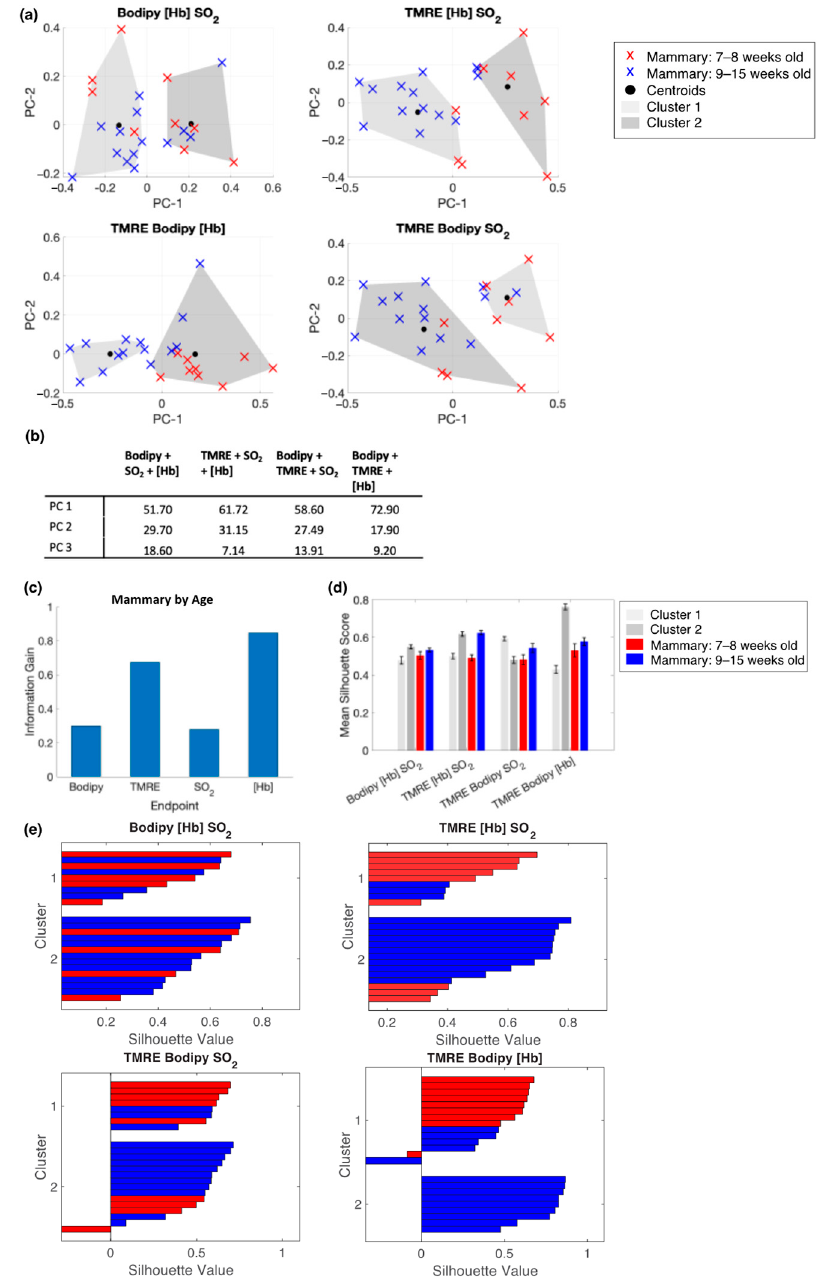
Figure 6. Bodipy FL C16-TMRE spectroscopy measurements reveal longitudinal changes in normal mammary glands throughout development. ( a ) Projections of the first two PCs show spectral cluster- ing results for four different combinations of the following endpoints: Bodipy FL C16 fluorescence intensity, TMRE fluorescence intensity, total hemoglobin concentration ([Hb]), and total oxygen saturation (SO 2 ). Fluorescence intensity is reported as the average intensity within 2.5 nm of the emission peak. ( b ) Table containing the variance described by each PC, by endpoint combination. ( c ) The calculated information gained from each variable. ( d ) The mean silhouette scores for cluster 1, cluster 2, data points with a true label of 7–8-week-old mammary, and data points with a true label of 9–15 week-old mammary. Error bars are SE. ( e ) Silhouette plots for each endpoint